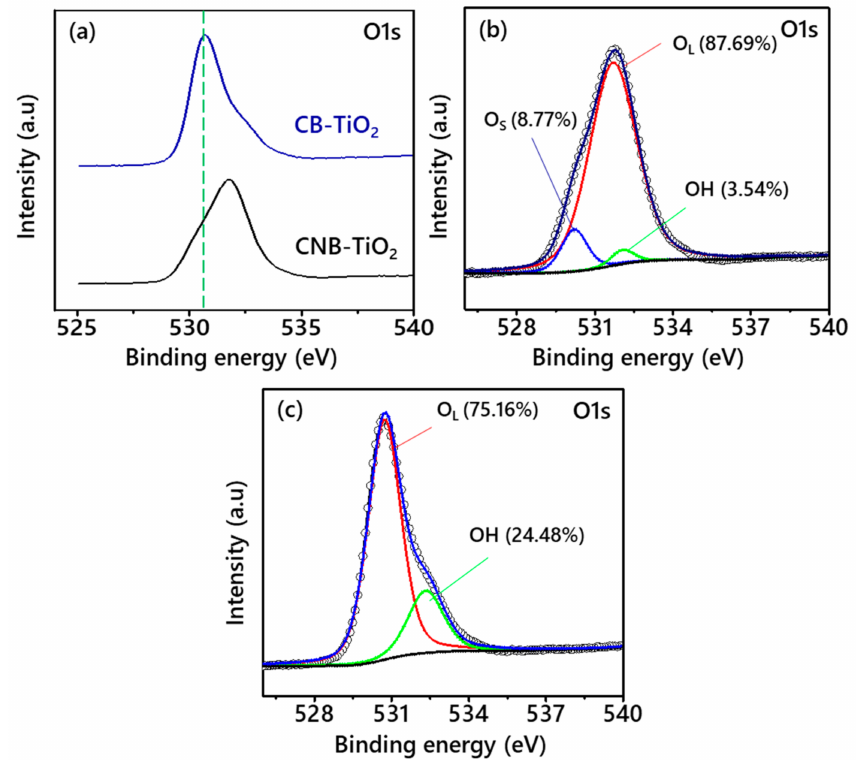
Figure 6. O1s XPS spectra ( a ) without deconvolution, and high resolution deconvoluted spectra of ( b ) CB-TiO 2 , and ( c ) CNB-TiO 2